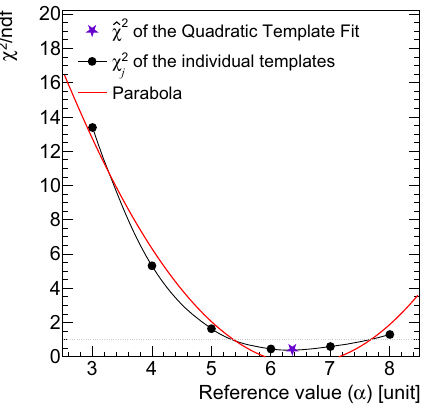
Fig. 7 Visualization of the χ 2 values of the templates in Example 3. A thin line connects these values. The red line displays a fitted parabola, which is not able to describe the χ 2 values adequately, which is indica- tive of a nonlinear problem. The star indicates the best estimator from the Quadratic Template Fit